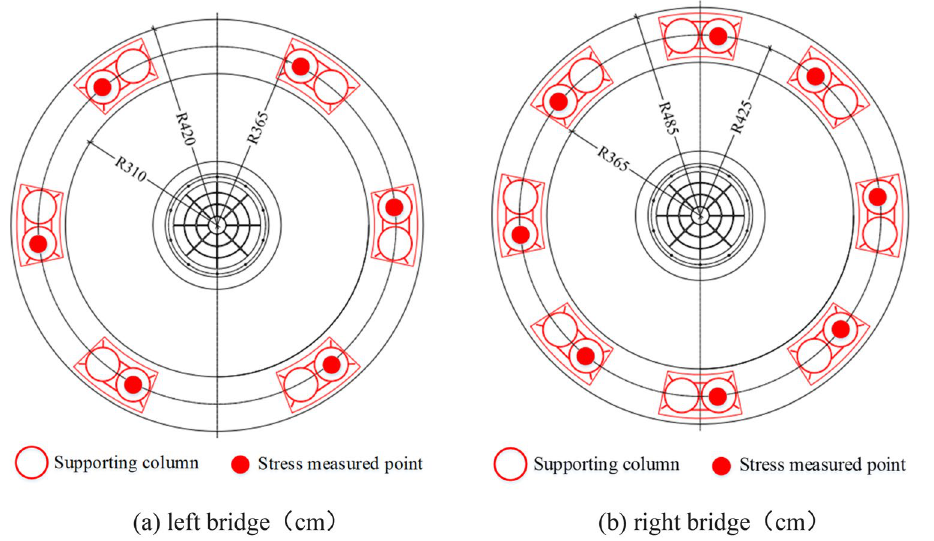
Figure 6. Stress measured points arrangement of supporting